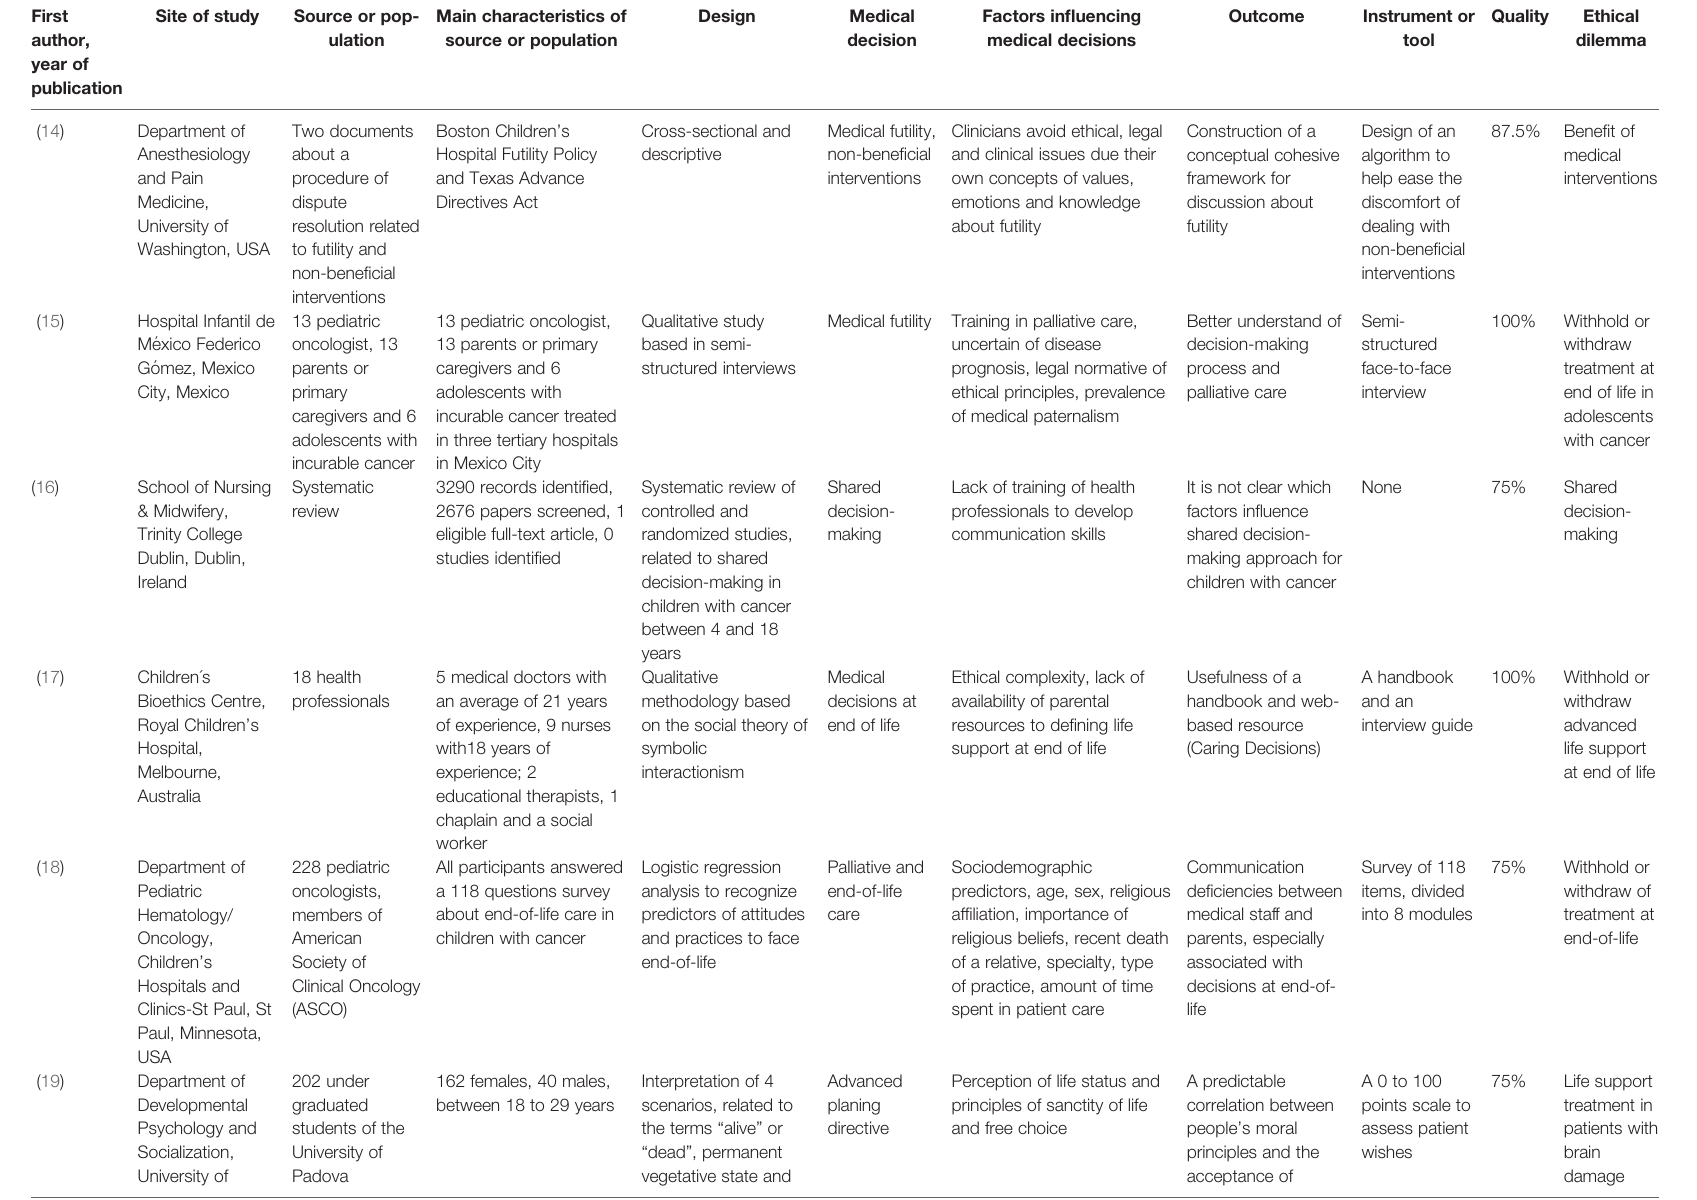
TABLE 3 | Classi fi cation of articles included in the systematic review with appraise study